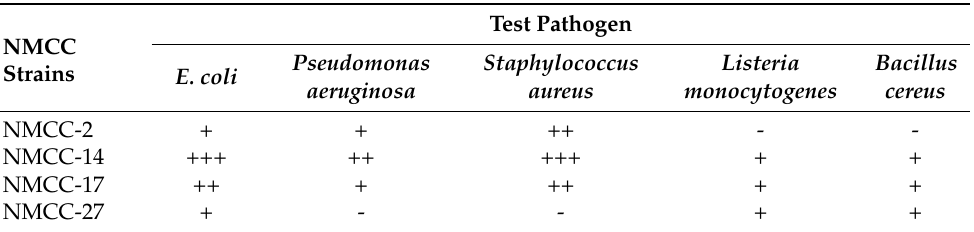
Table 5. Antibacterial activity of LAB strains against food pathogens and diameter (mm) of the respective inhibition zones.